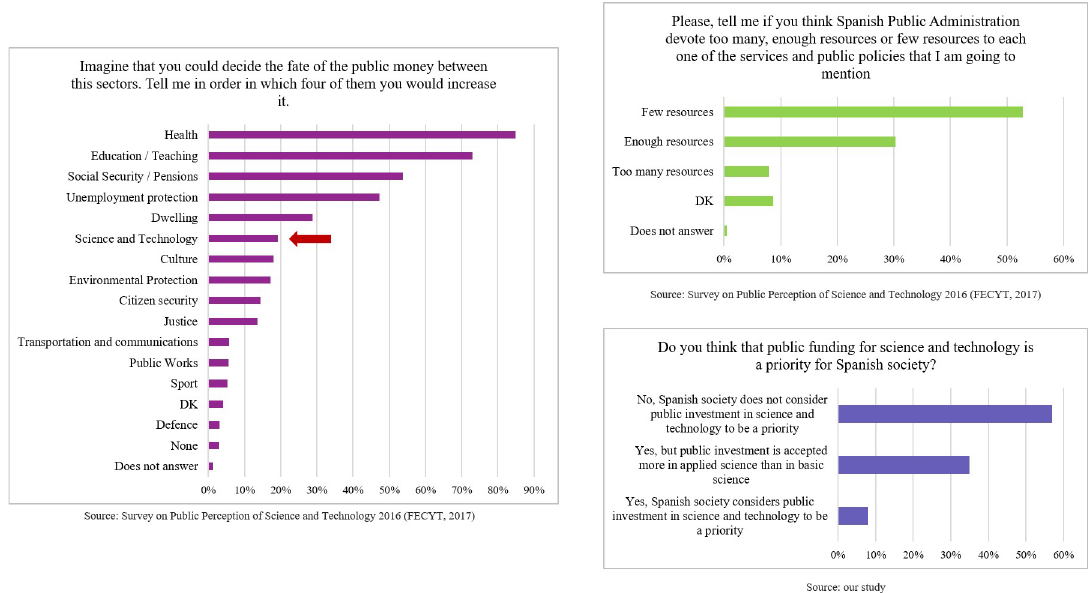
Fig 5. Prioritization of public spending in science and technology by society in general (FECYT data) and scientists (our data).